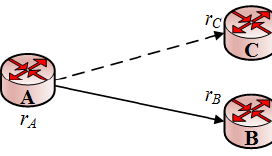
Figure 7. Illustration of dynamic transmit channel selection.